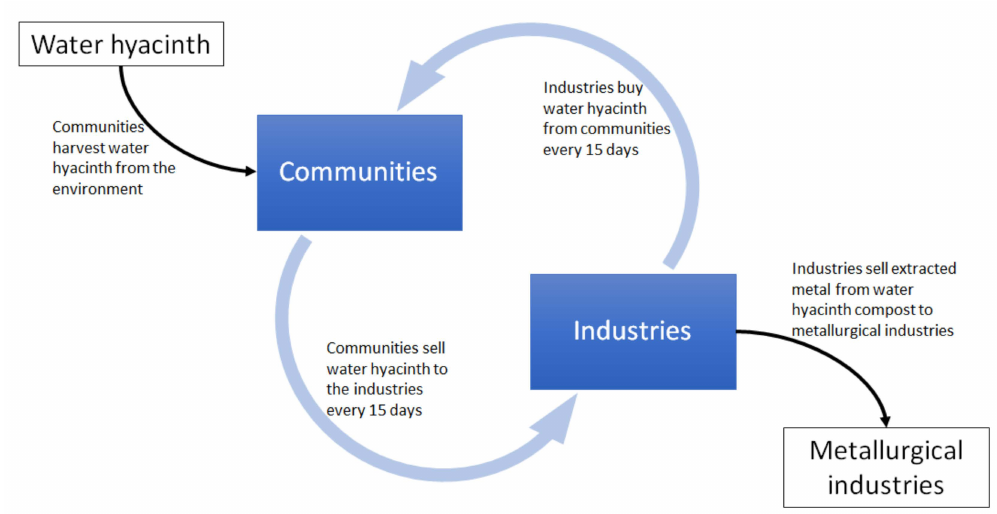
Figure 6. The water hyacinth supply and demand cycle when used as an industrial wastewater treatment. The plants will be extracted by the communities and sold to the industries. The latter use the whole plant to collect heavy metals from their wastewater. The industries can then compost the whole plants before extracting the heavy metals from the compost and selling them to metallurgical industries. Since water hyacinth can significantly reduce heavy metal levels in wastewater within 15 days, industries will be prompted to buy more water hyacinth from the communities after this period to treat the next wastewater batch. This cycle demonstrates how communities will benefit from the sale of water hyacinth and the industries will benefit from the cheaper wastewater treatment and sale of extracted metals from the water hyacinth